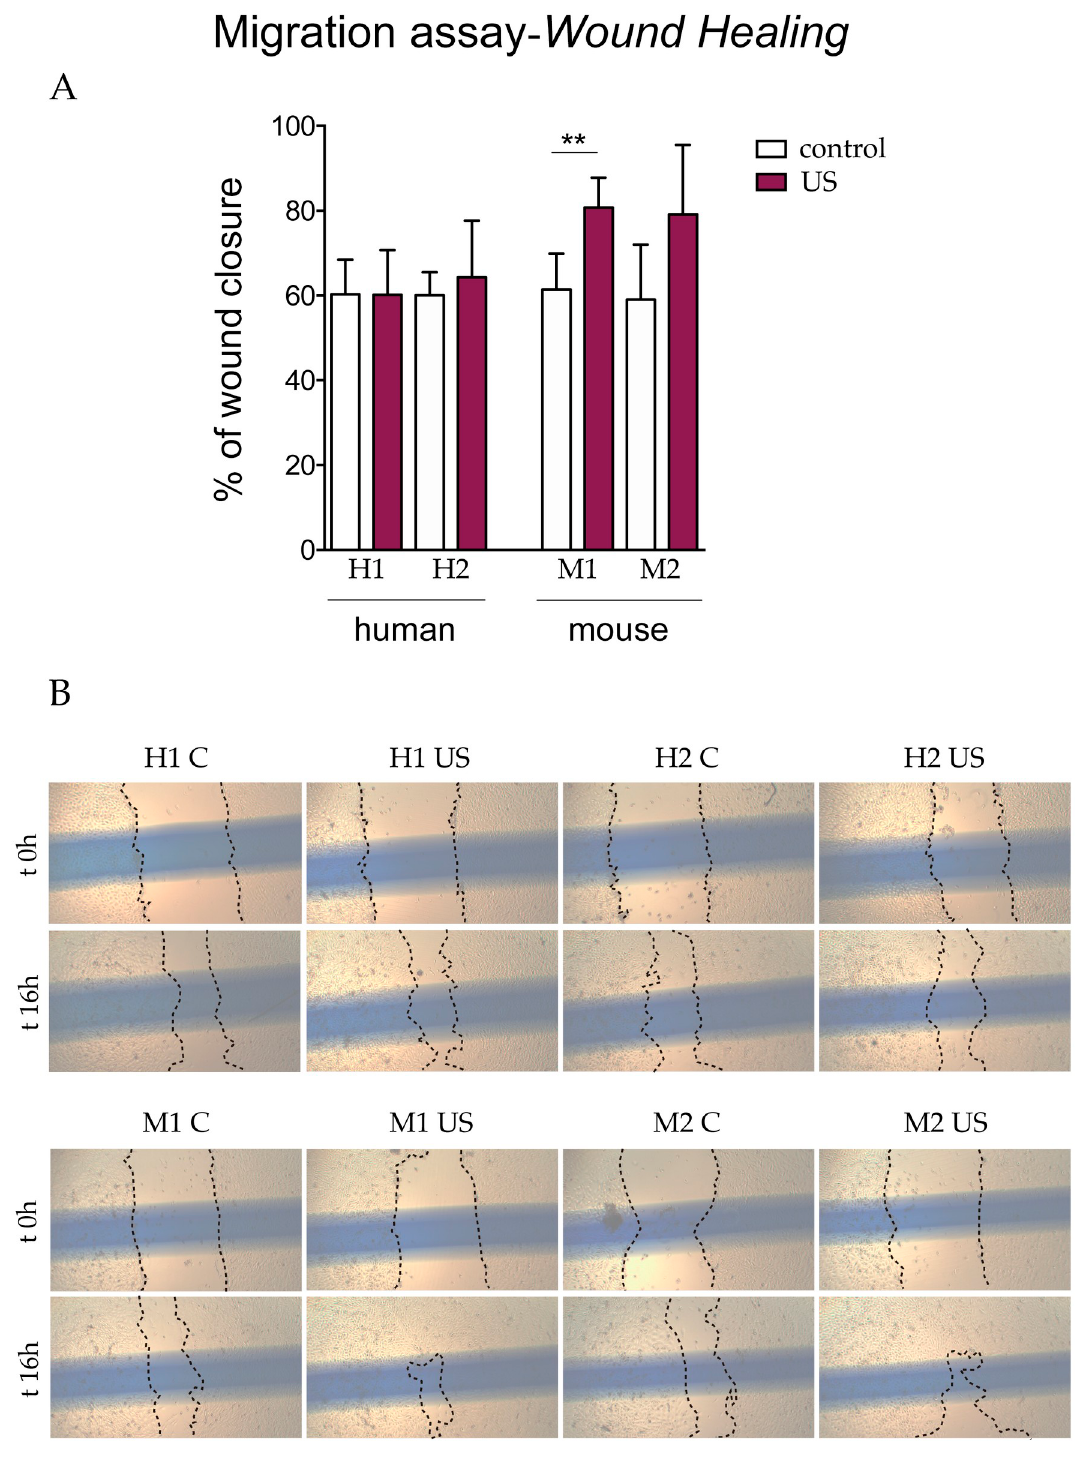
Fig 5. Wound healing migration assay. (A) Data are shown from a representative experiment out of five performed and denote mean ± SD (quantification at 16 h). Statistical analysis was performed using Student’s t test. �� p < 0.01. (B) Representative images of the wound at time 0 h and 16 h after scratching. Shown are two independent samples of mouse (M1 and M2) and human (H1 and H2) s-MPs under control conditions or treated with ultrasound (US).